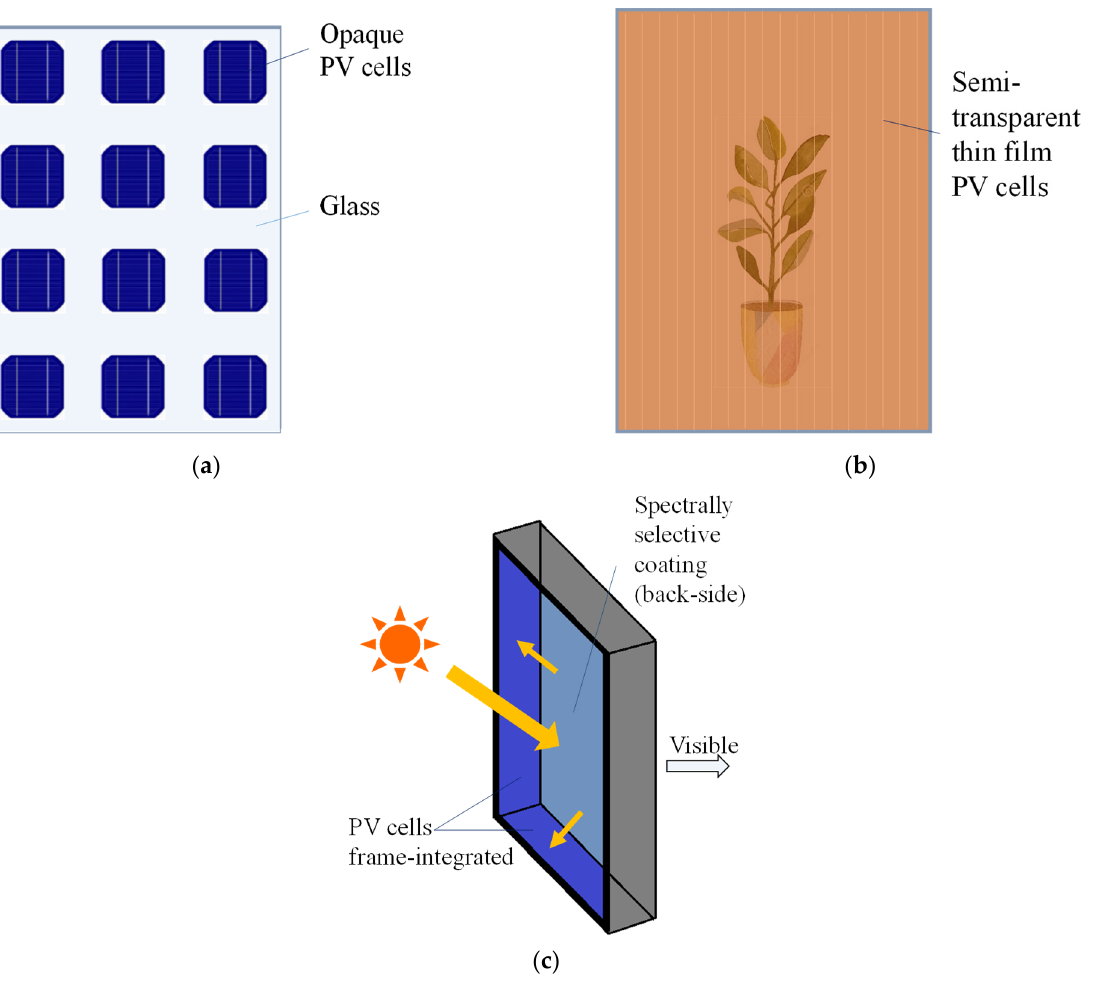
Figure 6. PV configurations in semi-transparent BIPV-T solutions: ( a ) PV cell cladding collectors [138,139], ( b ) semi-transparent thin-film PV cells [140,141] and ( c ) frame-integrated PV cells [142].